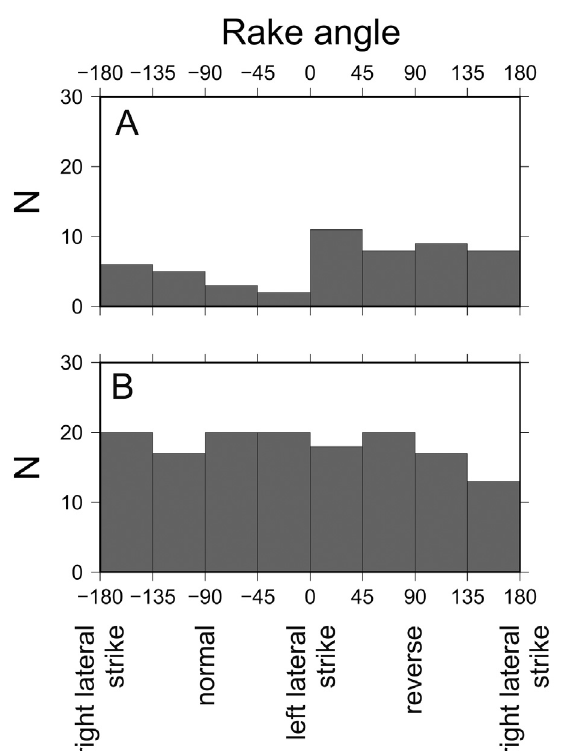
Figure 12. Distribution of rake angles for the mechanisms of Fig- ure 11. In A we represents rake angles of events located a.s.l. while in B the same for the other